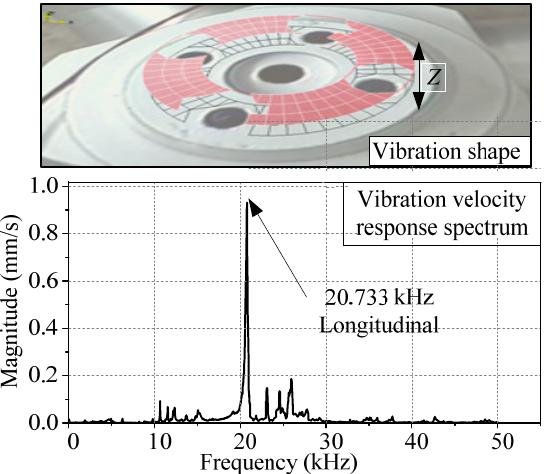
Figure 15. Vibration measurement result of composite power-superimposing vibrator.